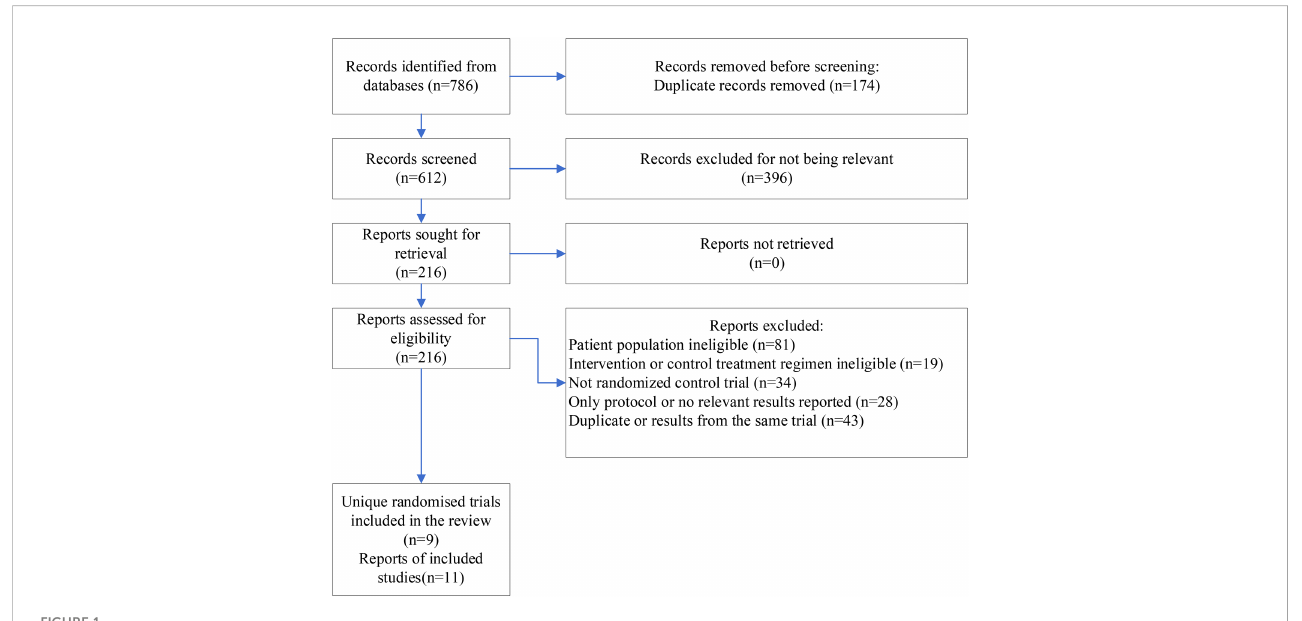
FIGURE 1 PRISMA fl owchart describing the study selection